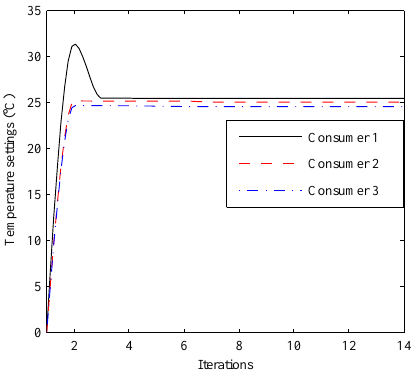
Figure 8. The convergence of the temperature settings.